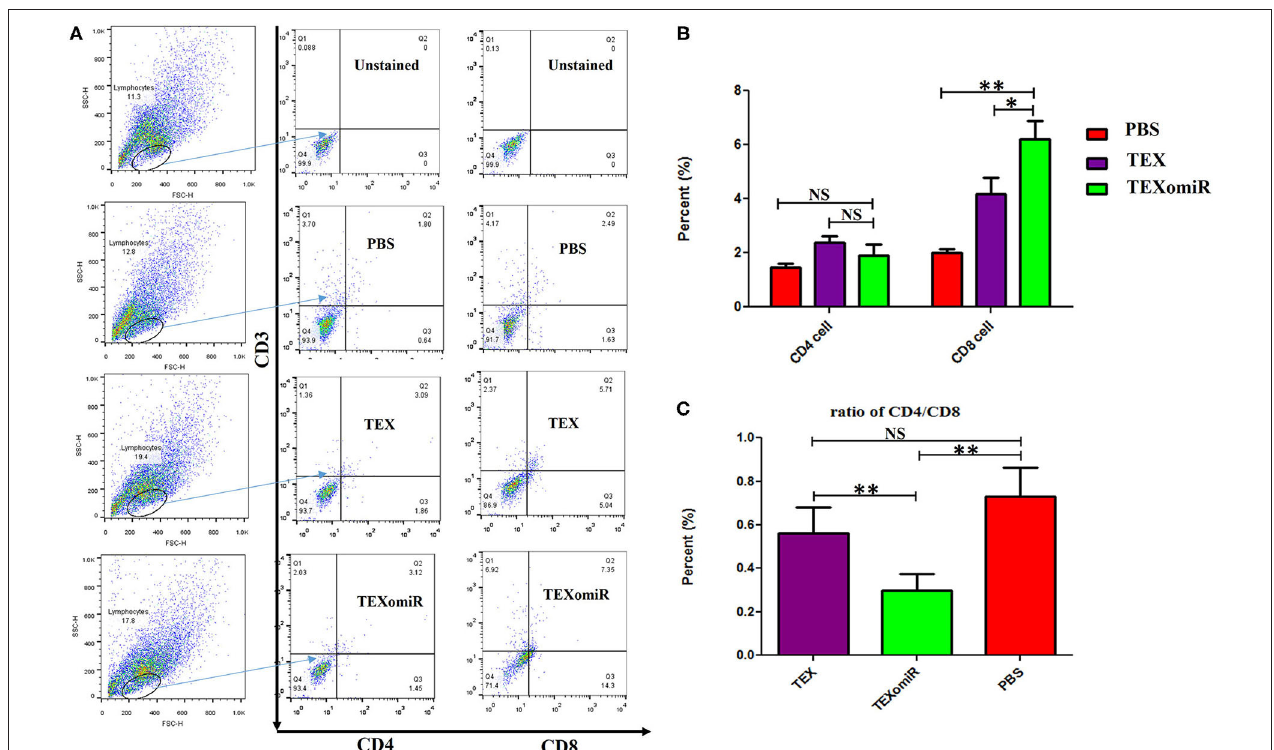
FIGURE 8 | The effect of TEXomiR on tumor lymphocytes. (A) Flow cytometry analysis of CD4 T + and CD8 T + lymphocytes in tumor from CT-26 tumor-bearing mice treated with TEXomiR, TEXs, and phosphate-buffered saline (PBS). (B) A significant increase in the number of CD8 + T lymphocytes was detected in the TEXomiR group compared with the TEXs and PBS groups. (C) The ratio of CD4/CD8 showed a significant decrease in the TEXomiR group compared with the TEXs and PBS groups. The data are presented as mean ± SD. ** P < 0.01, * P < 0.05. One-way ANOVA was used to make comparisons between groups. TEXomiR, miR-124-3p-enriched TEXs; TEX, tumor